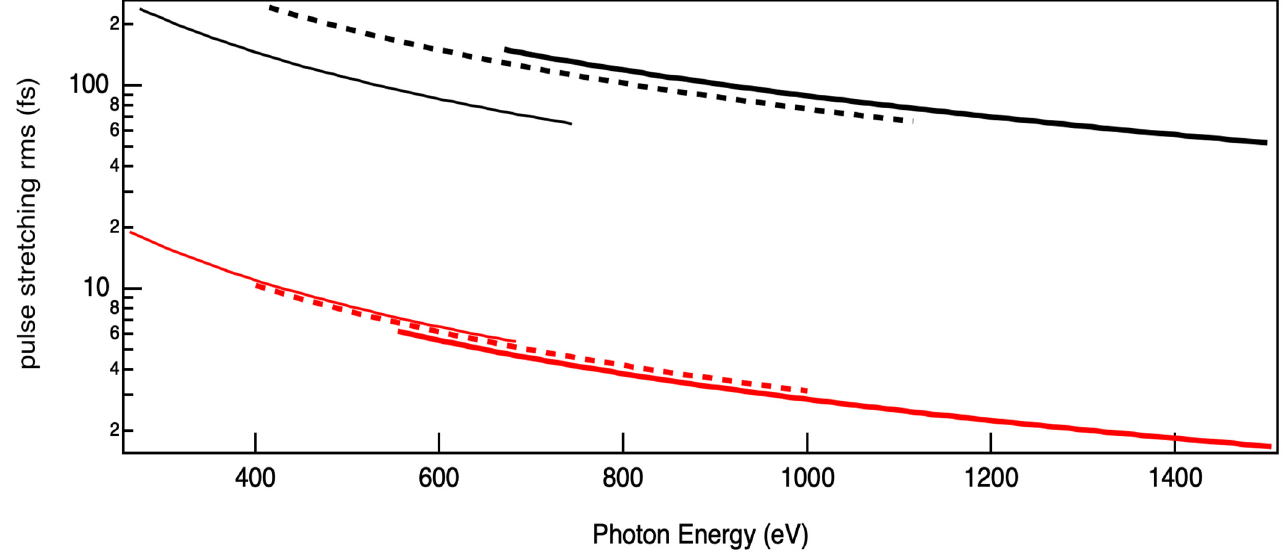
Figure 5. Calculated rms time elongation for the low resolution grating (red curves) and for the 3